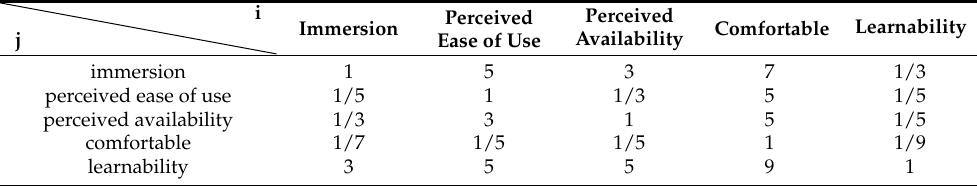
Table 1. Judgment matrix of decision layer indicators of MR seismic retrofitting training system.